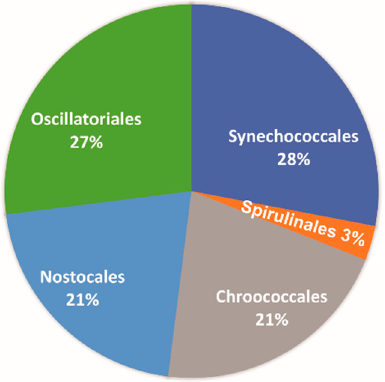
Figure 6. Pie diagrams presenting the percentage of each Cyanobacteria order.